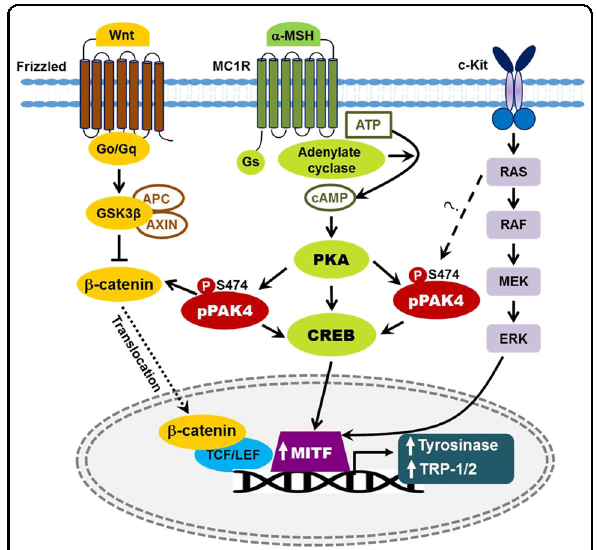
Fig. 5 PAK4-mediated signaling pathways in melanogenesis. PAK4 is activated downstream of PKA in the α -MSH signaling pathway and activates the CREB – MITF pathway. PAK4 phosphorylates β -catenin and activates TCF/LEF-dependent transcription, but the Wnt ligands that activate PAK4 remain unclear. PAK4 also functions downstream of Ras, but the exact mechanism is unknown. MITF microphthalmia- associated transcription